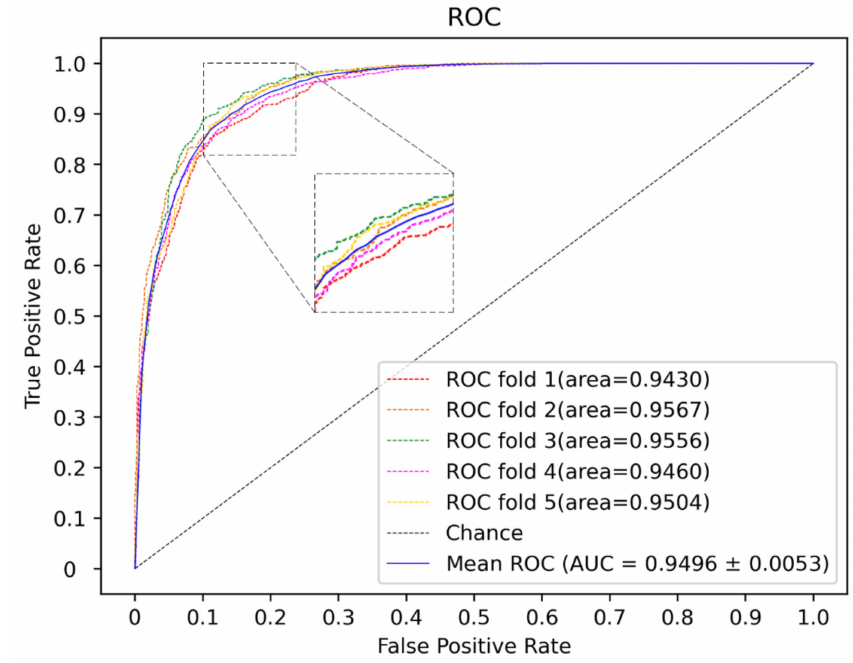
Figure 6. The ROC curves of our method.